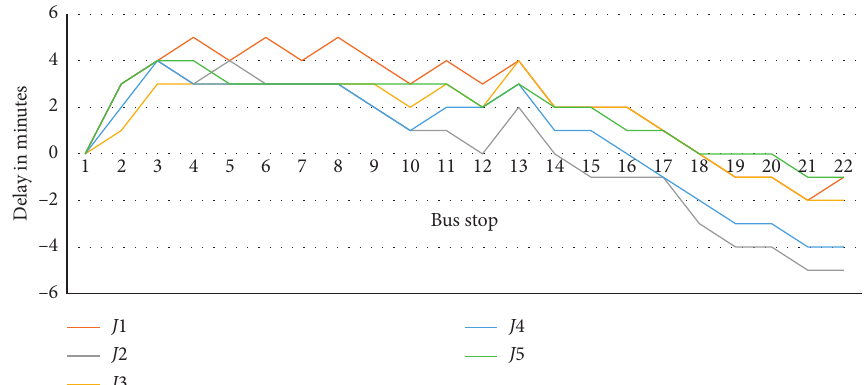
Figure 4: Delay at each bus stop associated with a journey performed by bus “5676” during a 5-day working